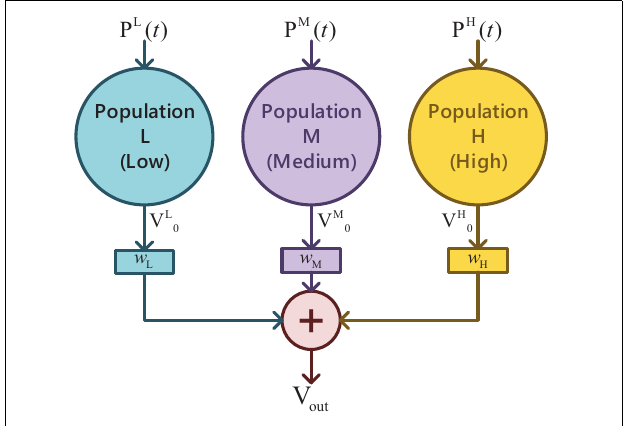
FIGURE 6 | The simplified extracellular electric field and its equipotential lines generated by